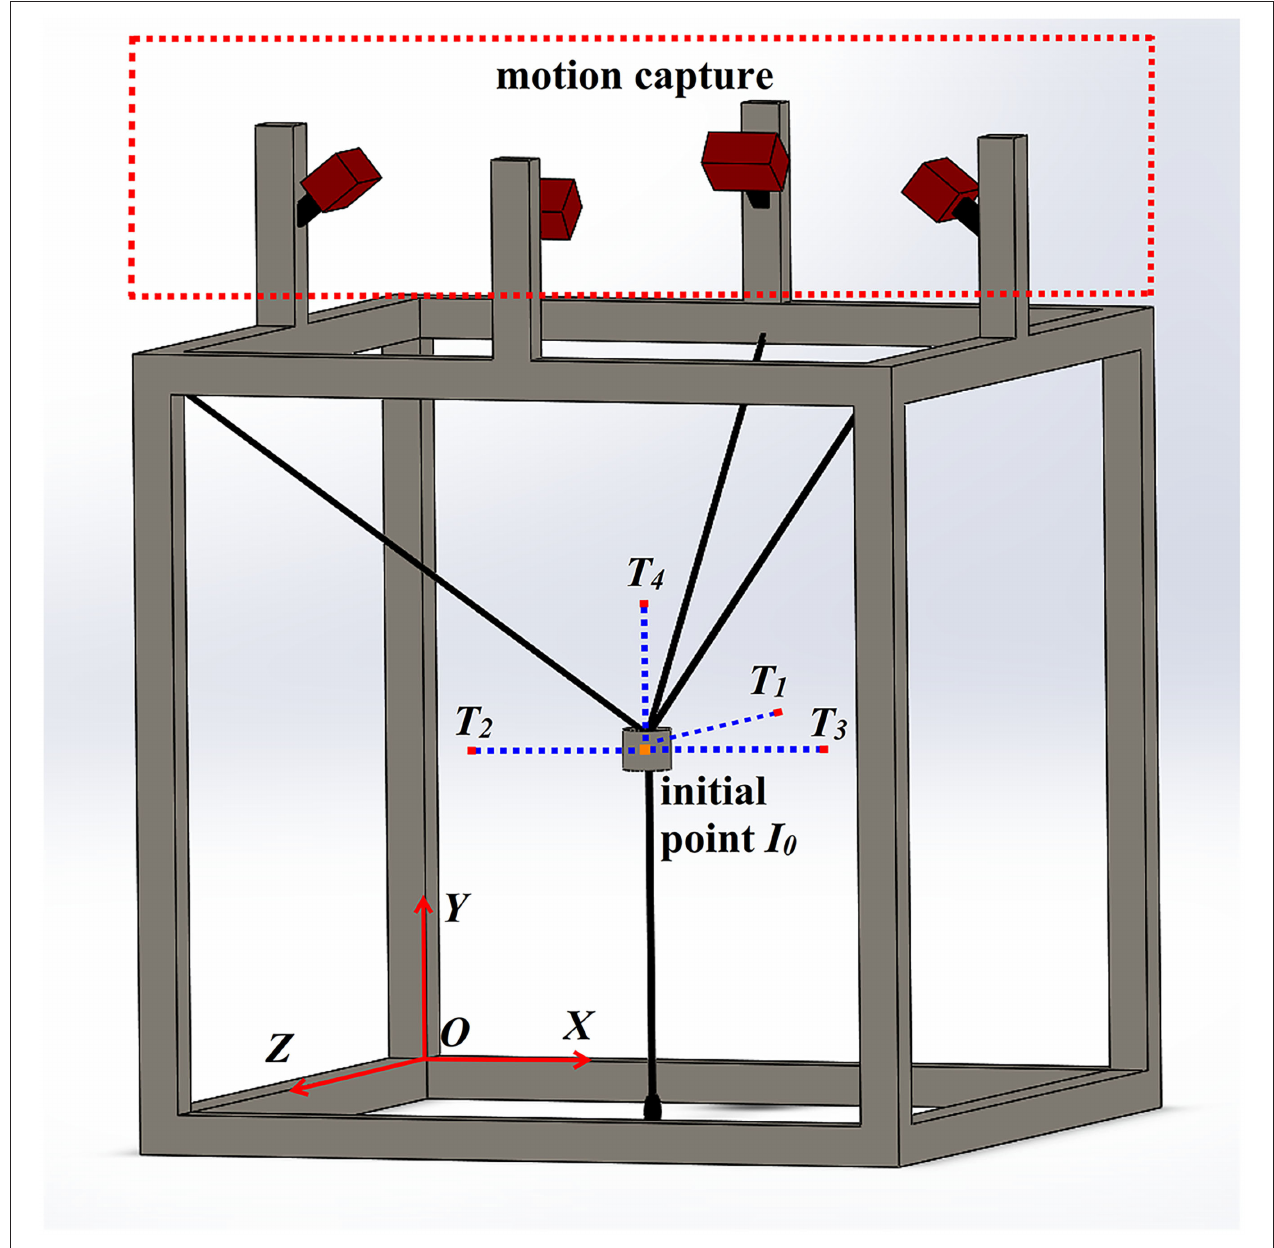
FIGURE 3 | The design of a three-dimensional reaching task, which including four point-to-point tracking subtasks.